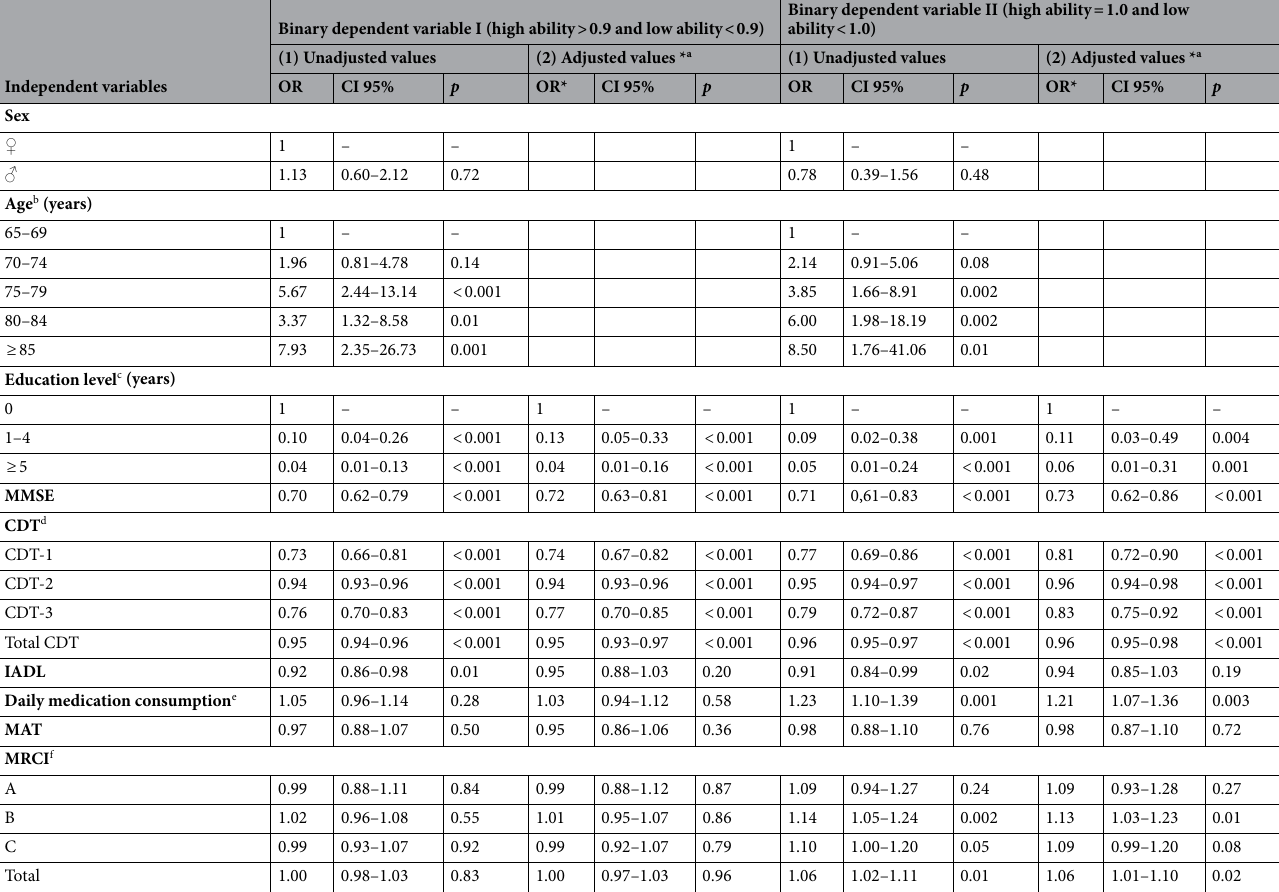
Table 1. Logistic regression models. a Sex- and age-adjusted values. b Age reclassification. c Education level